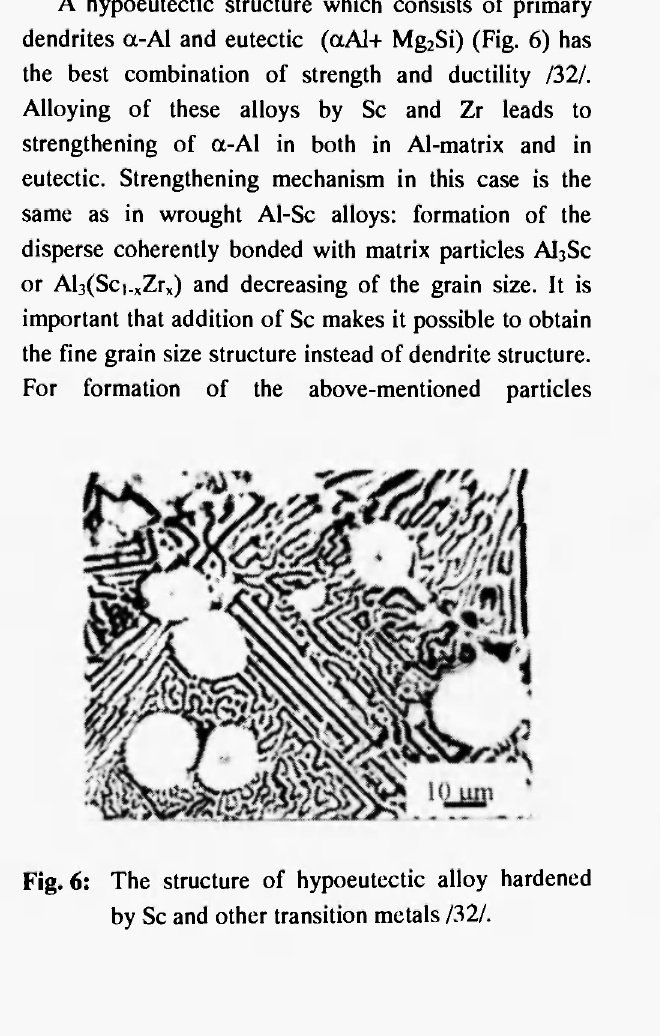
Fig. 6: The structure of hypoeutectic alloy hardened by Sc and other transition metals